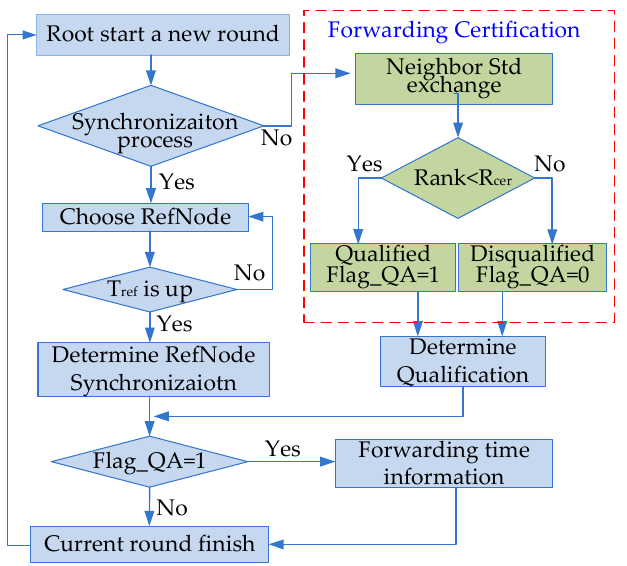
Figure 3. Flow chart of the time synchronization protocol based on dynamic routing and forwarding certification (DRFC-TSP).